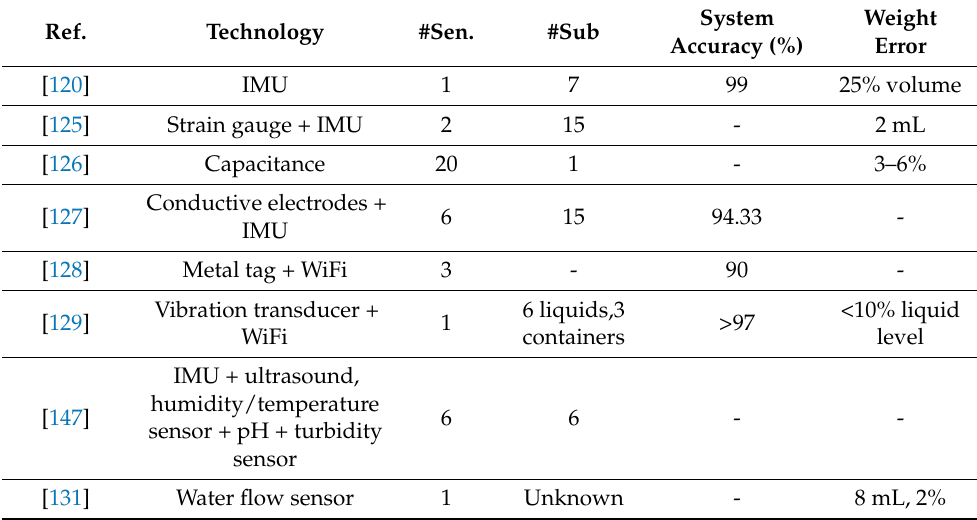
Table 4. Summary of top eight smart containers